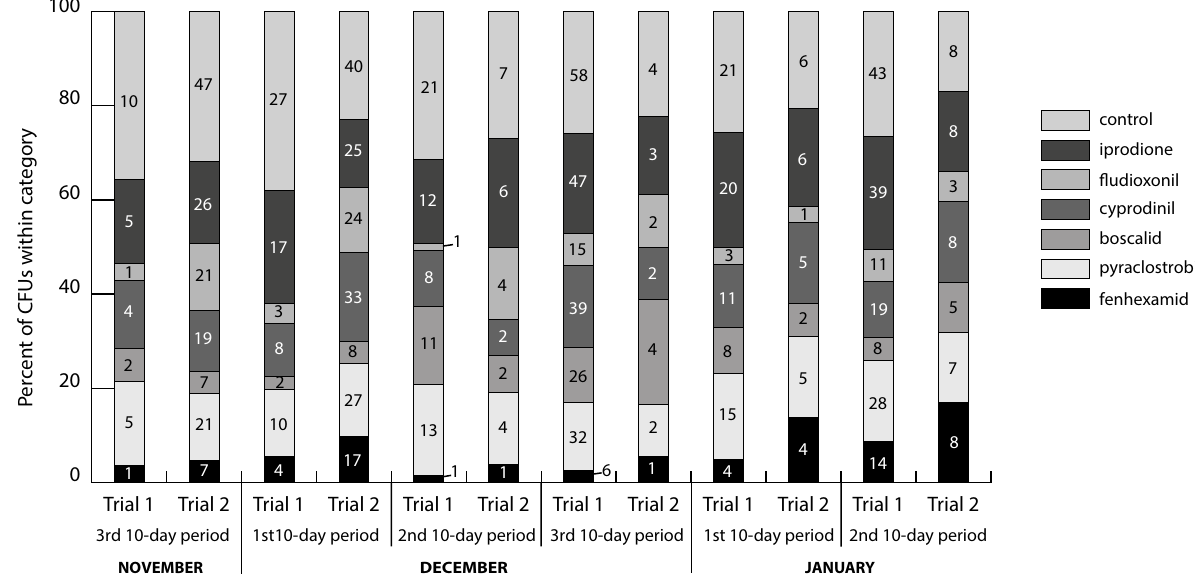
Figure 1. Number of airborne B. cinerea conidia trapped in different fungicide amended media during 2012-13 (Trial 1) and 2013-14 (Trial 2) growing periods. The number of CFUs on fungicide enriched selective media are indicated in each bar and expressed as % of the total number of CFUs on all the plates including controls (top bars). The discriminatory concentrations used were: 1 mg L -1 fenhexamid, 10 mg L -1 pyraclostrobin + 100 mg L -1 SHAM, 10 mg L -1 boscalid, 10 mg L -1 cyprodinil, 1 mg L -1 fludioxonil and 3 mg L -1 iprodione.